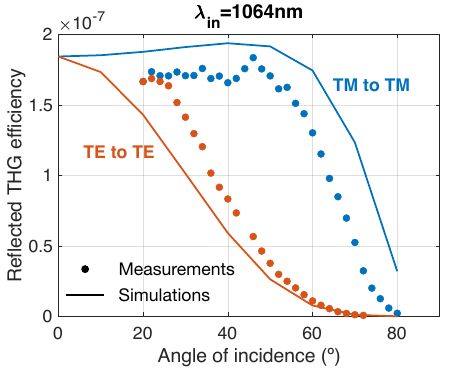
Fig. 3. Transmitted (blue) and reflected (red) measured (full circles) and predicted (solid curves) THG efficiency as a function of incident angle from a crystalline silicon wafer when the incident field is tuned at 1064nm. A TM (blue) and a TE- polarized (red) TH field was detected for TM and TE-polarized incident light,